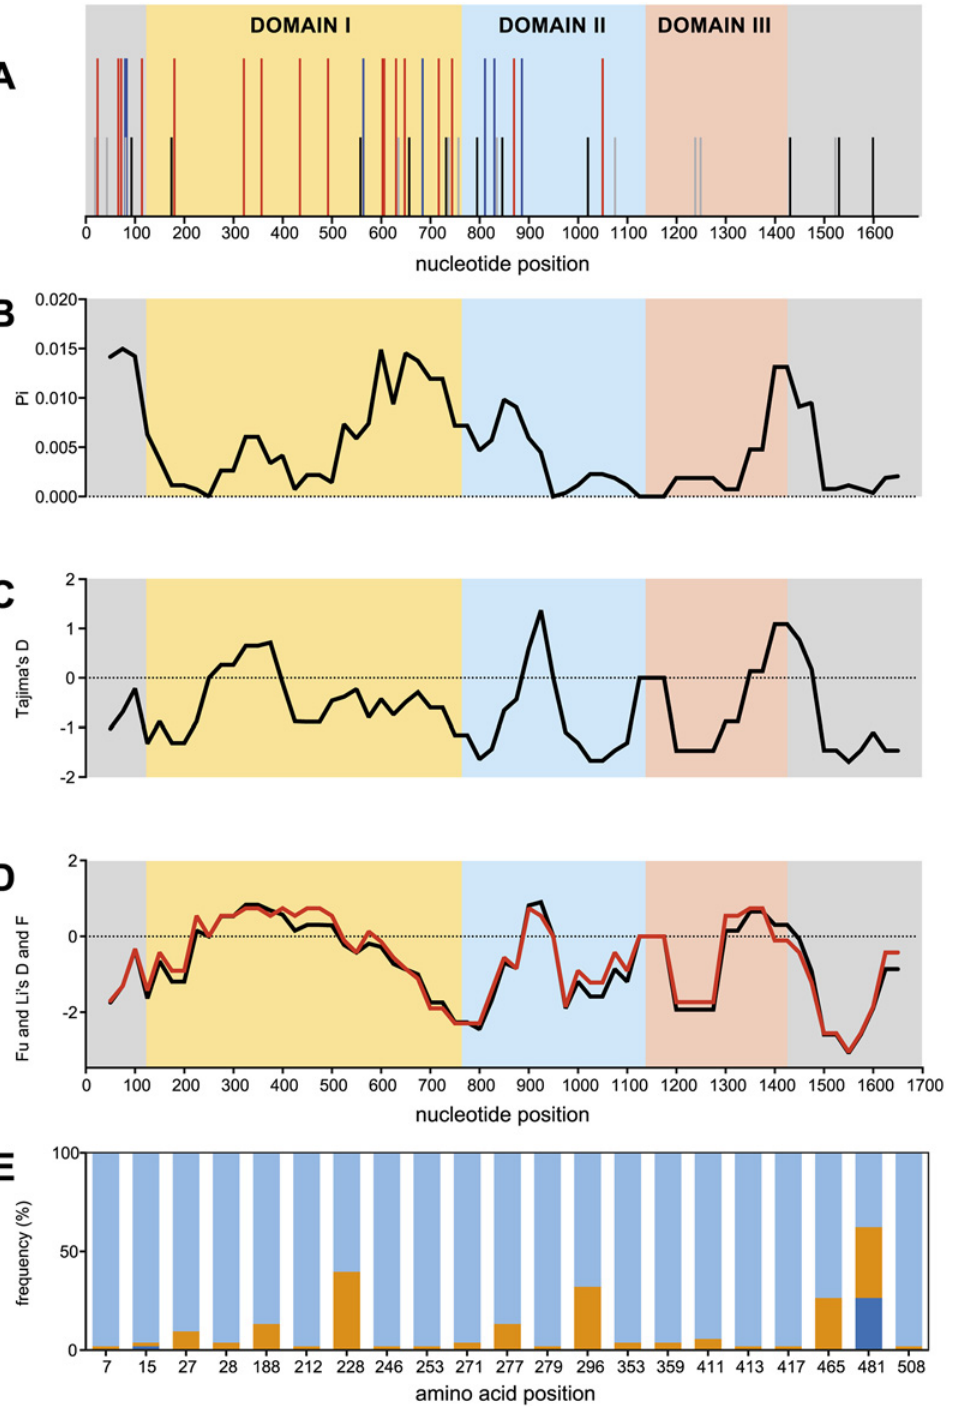
Fig 2. Analyses of the genes encoding the full length PkAMA1 protein. A) Schematic representation of the pkama1 gene, indicating the locations of all non-synonymous (NS, red lines), synonymous (SP, blue lines) and NS and SP singleton (black and grey lines, respectively) SNPs. B) Sliding window analysis showing the average pairwise nucleotide diversity (Pi) values in Pkama1 for the 52 sequences included in the analysis. A window size of 100 bp and a step size of 25 bp were used. C) Sliding window calculation of Tajima ’ s D. A window size of 100 and a step size of 25 were used. D) Sliding window calculation of Fu&Li ’ s D (red line) and F (blue line). A window size of 100 and a step size of 25 were used. E) Amino acid frequencies. The frequencies of 21 amino acid polymorphic positions are indicated by the proportion of each bar and its color. Light blue, most prominent amino acid; orange, second most prominent amino acid; dark blue, least prominent amino